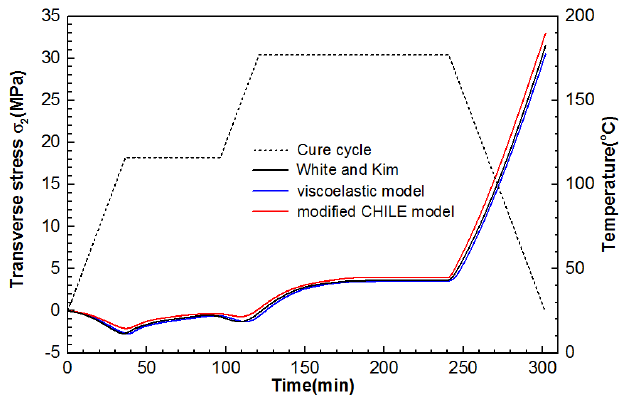
Figure 11. Stress σ 2 development in the 0 ◦ ply at x = 5.08 and y = 5.08 of the composite laminate under manufacture recommended cure cycle from the modified CHILE and viscoelastic models.